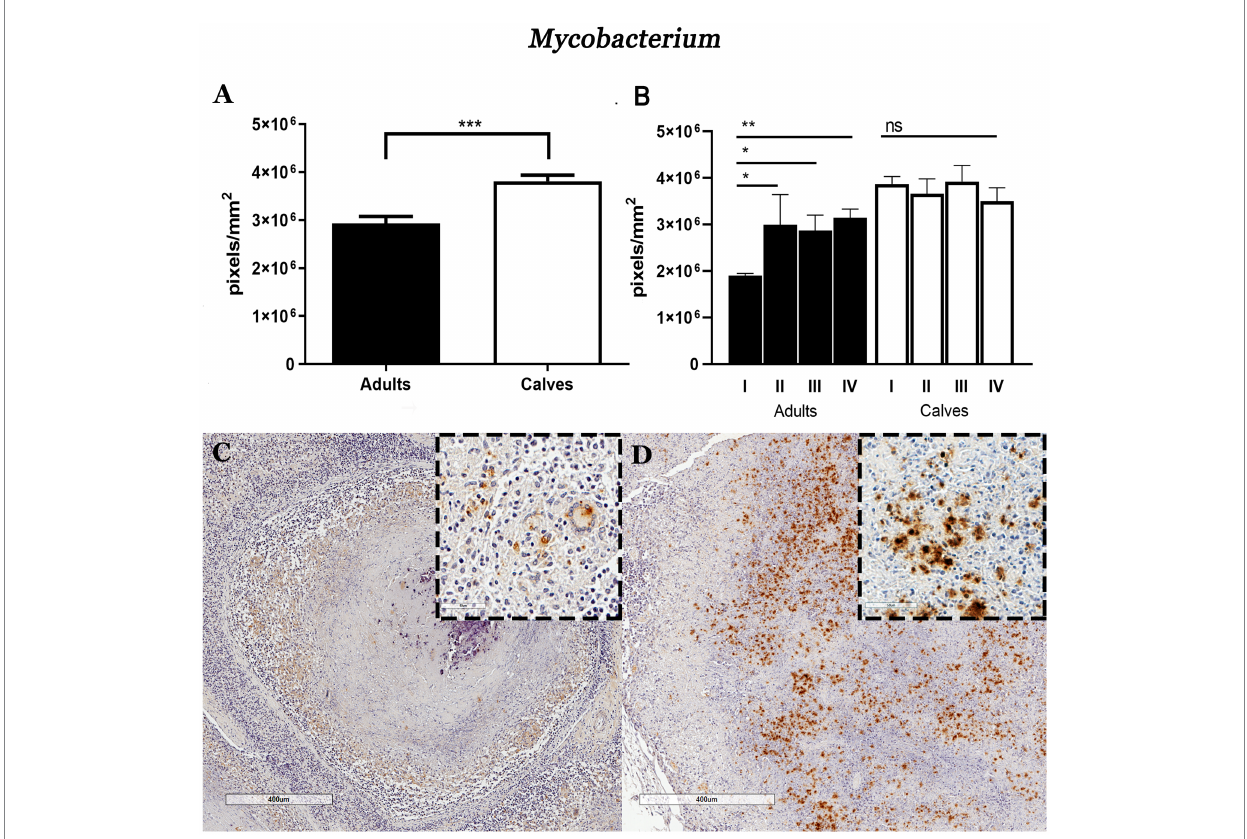
FIGURE 1 Granulomas of calves Mycobacterium bovis naturally infected show higher mycobacteria immunolabeling compared to adult cattle. (A) Average number of pixels positive for the IHC anti-mycobacterium staining in granulomas and stages from adult and young cattle, respectively. (B) Mann–